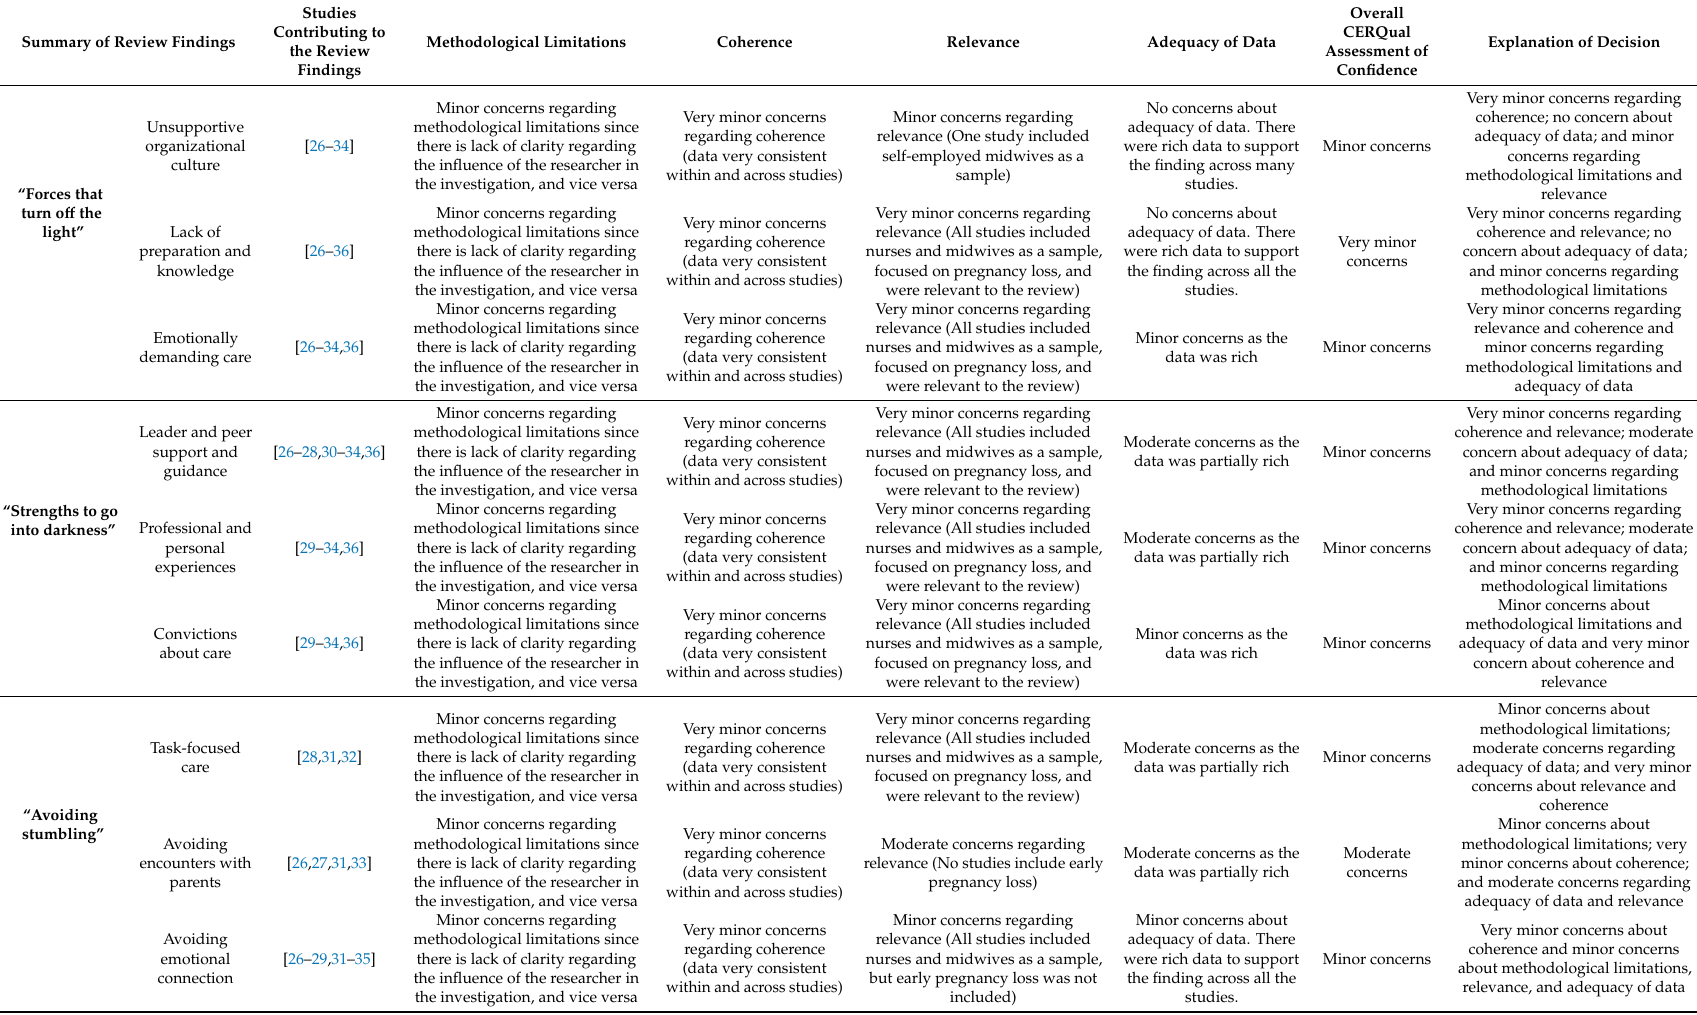
Table A2. Confidence in the Evidence from Reviews of Qualitative research (CERQual) evidence